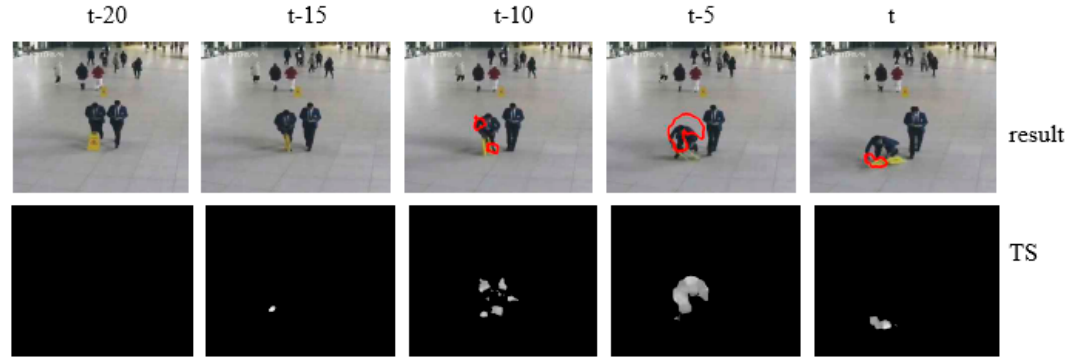
Figure 14. Examples of detection results for abnormality from the No. 7 data.